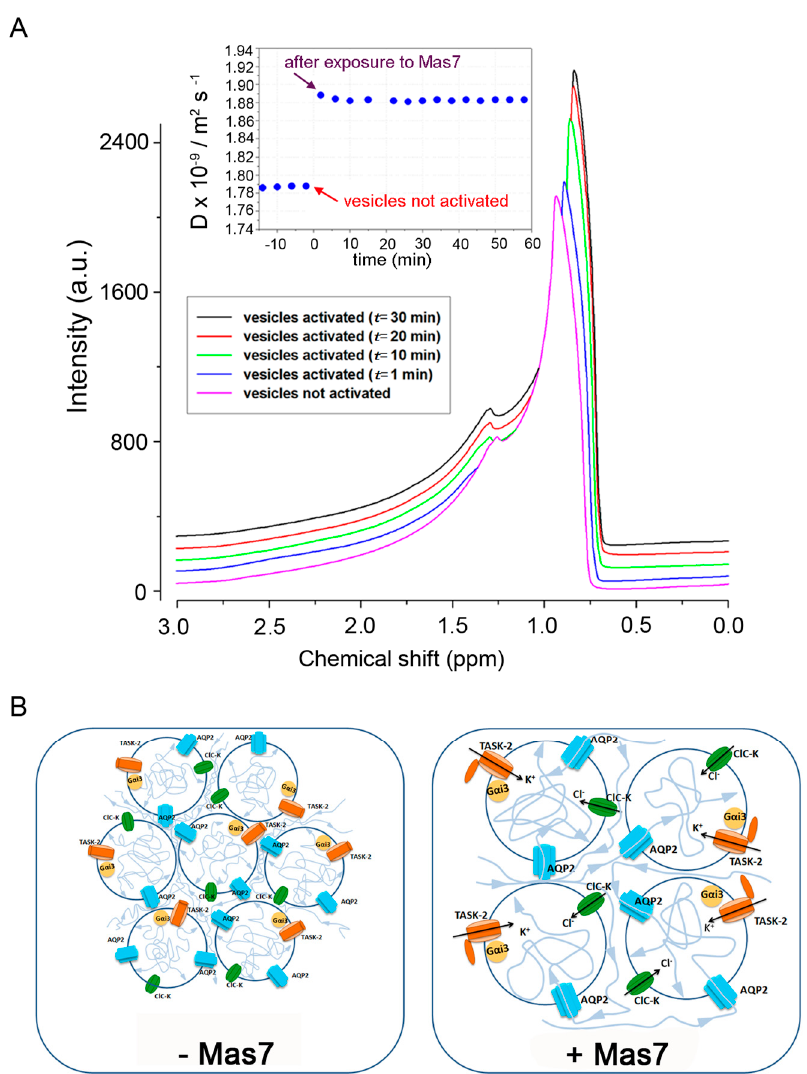
Figure 4. NMR-Diffusometry. Water self-diffusion coefficient D measurement before and after the addition of Mas7 (A inset). ( A ) Before activation with Mas7, the measured 1 H diffusion coefficient D of the vesicles solution was (1.78 ± 0.01) × 10 − 9 m 2 s − 1 . After the addition of Mas7, D value monitored at the time t = 1 min was equal to (1.89 ± 0.01) × 10 − 9 m 2 s − 1 and reached a steady state at a constant value